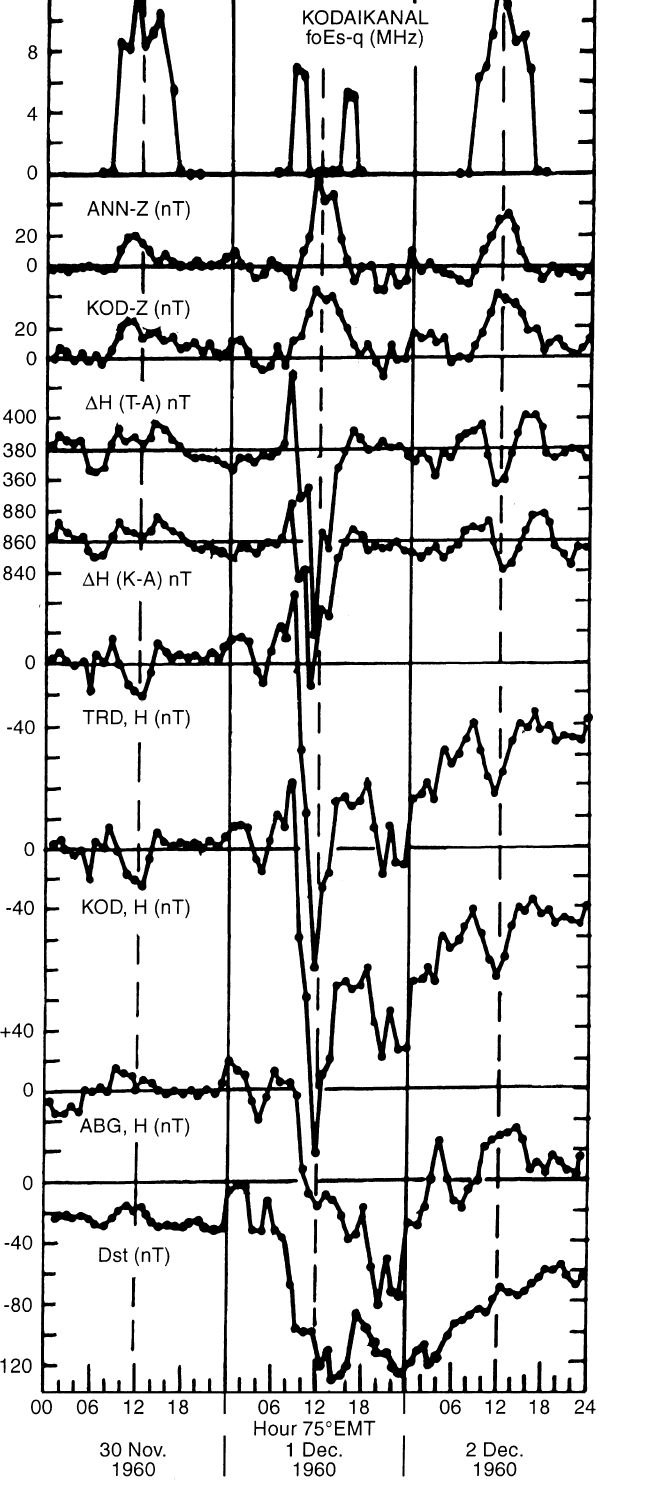
Fig. 6. The storm time variation of Dst index, H fields at ABG, KOD, TRD, (cid:68) H (T-A), KOD- Z , ANN- Z and f o Es at Kodaikanal during sudden commencement storm starting at 0214 h 75 (cid:14) E on 22